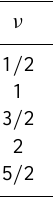
Fig. 2. Impact of higher-order derivatives. Table 3. Radial distance where the kernel is 1/2 for different values of ν .